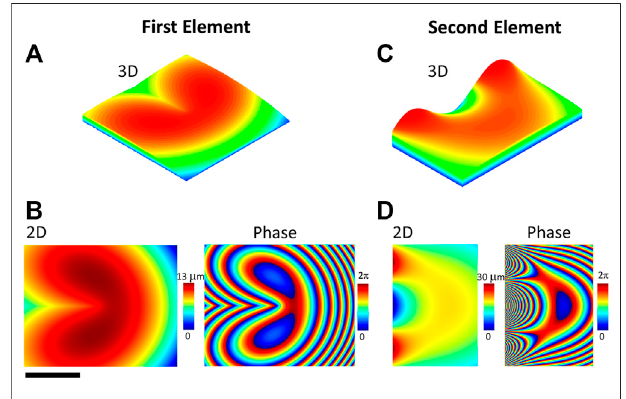
FIGURE 1 | The mode-sorter comprising two elements. 3D (A,C) and 2D (B,D) representations of the fi rst (A,B) and second (C,D) elements are presented. In 2D, both height and phase accumulation are described. Scale bar, 50 μ